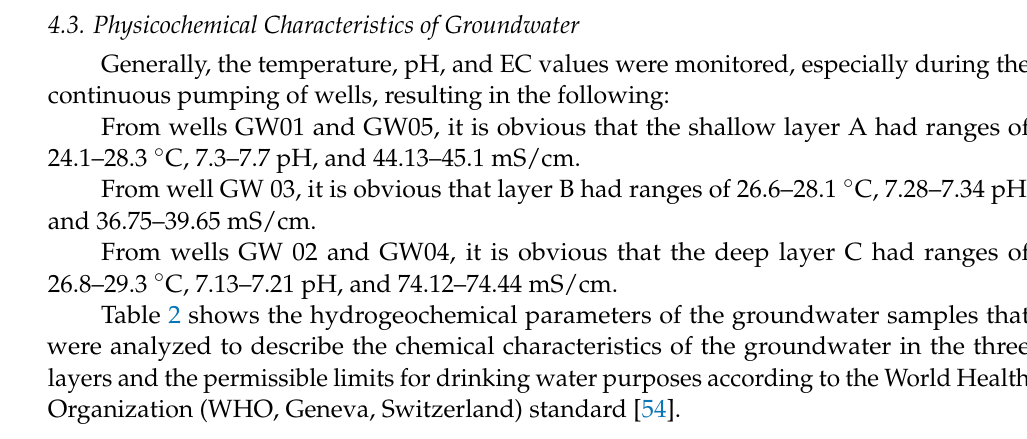
Table 2. The physicochemical analyses of groundwater